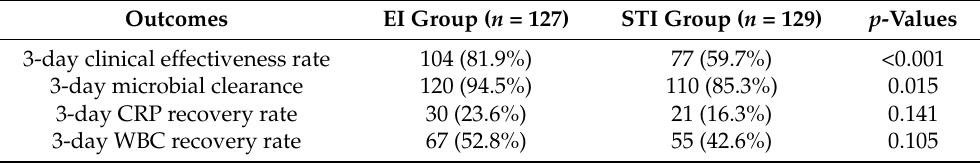
Table 2. Univariate analysis results of EI of meropenem effectiveness outcomes.